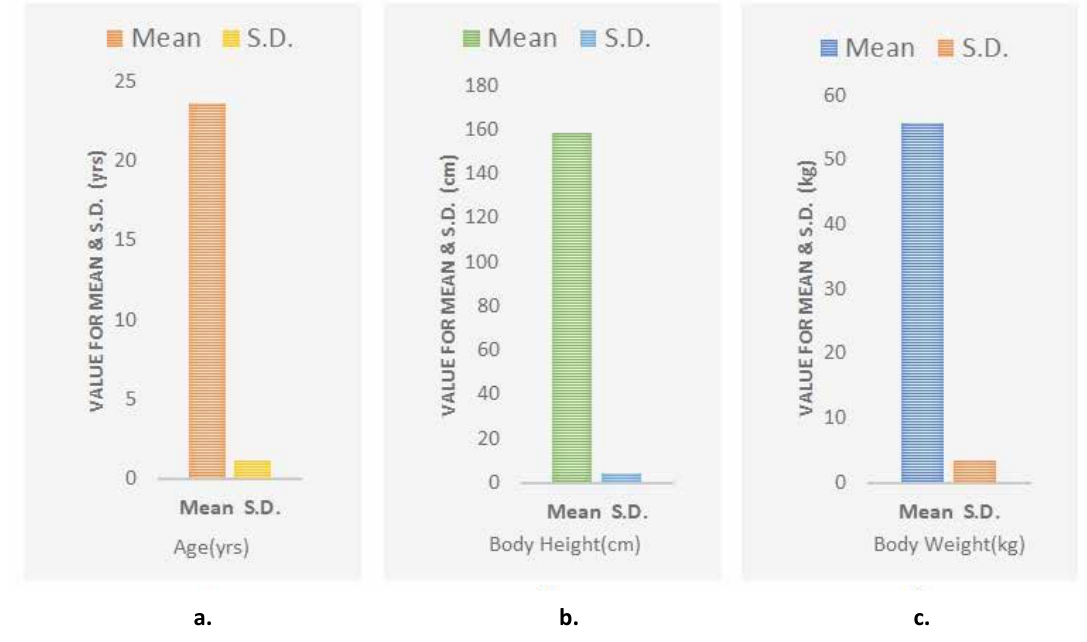
Figure 4. Demographics of subjects showing It is evident from the results that insignificant differences were noted between BPI and Control groups of girls on Maximal Oxygen Consumption (VO max) since 2 the p-value .431 was greater than (p>0.05). In addition, the Partial Eta Squared value showed that 6-weeks of bhastrika pranayama intervention had a positive effect of 1.3% on the BPI group regarding the parameter Maximal Oxygen Consumption (VO 2